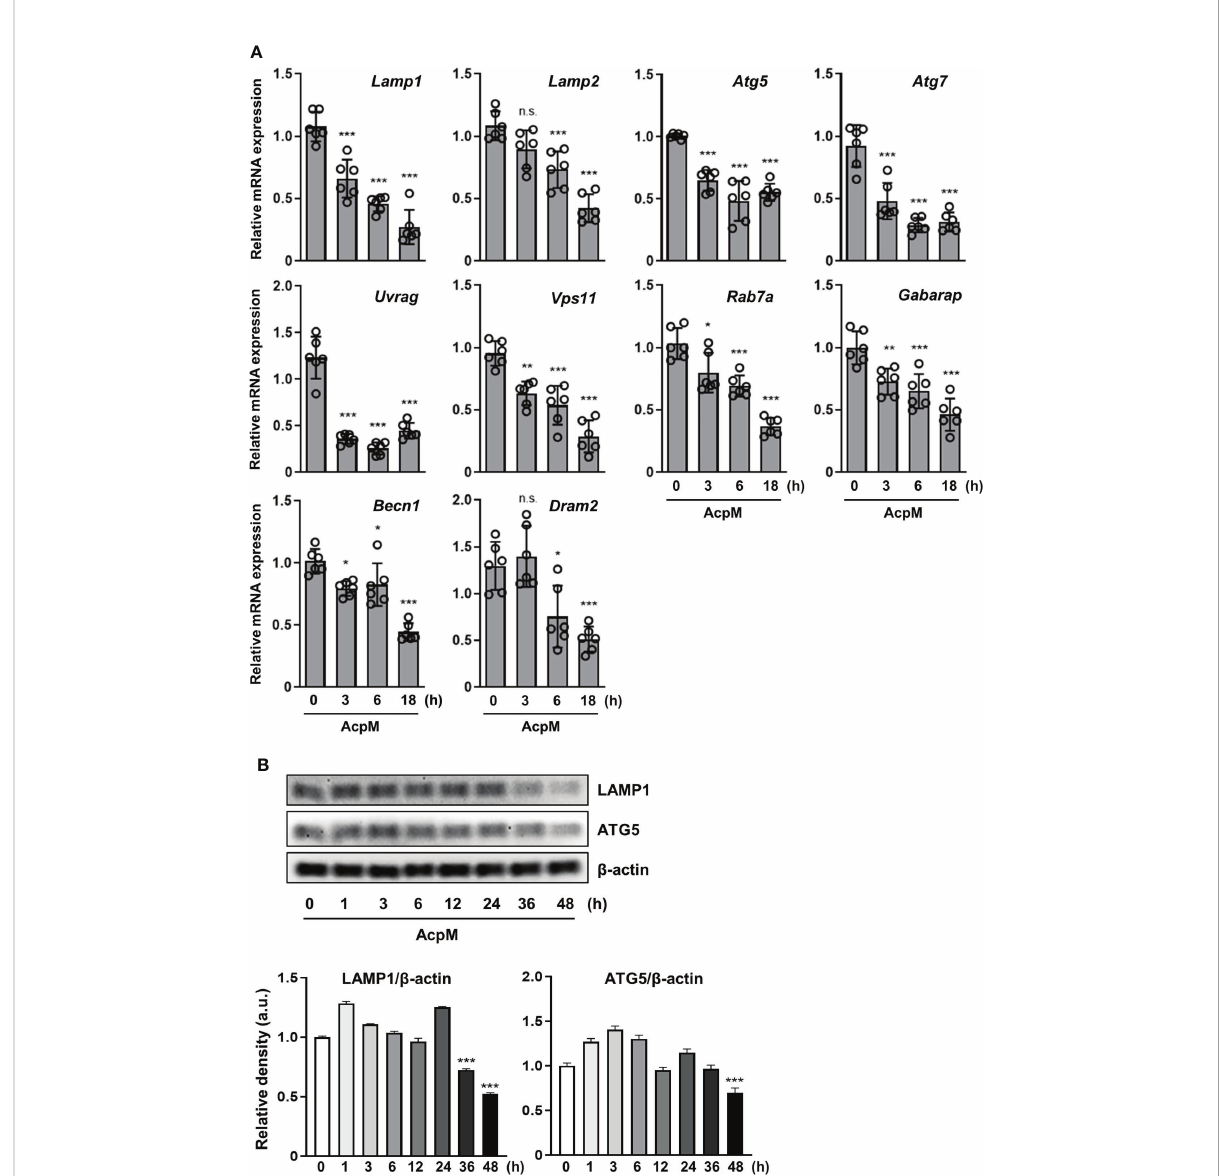
FIGURE 2 AcpM suppresses various autophagy and lysosomal genes. (A) BMDMs were treated with recombinant AcpM (10 m g/ml) for the indicated times. Total RNAs extracted from the cells were then subjected to qRT-PCR analysis to measure the expression of autophagic/lysosomal genes. (B) BMDMs treated with recombinant AcpM (10 m g/ml) for the indicated times were harvested, lysed, and subjected to immunoblot analysis to measure the LAMP1 and ATG5 expression. The representative image (upper panel) and the densitometric analysis (lower panel) of protein bands were presented. Statistical analysis was determined with one-way ANOVA and presented as means ± SD from at least three independent experiments performed. * p < 0.05; ** p < 0.01; *** p < 0.001. a.u., arbitrary unit; n.s., not signi fi